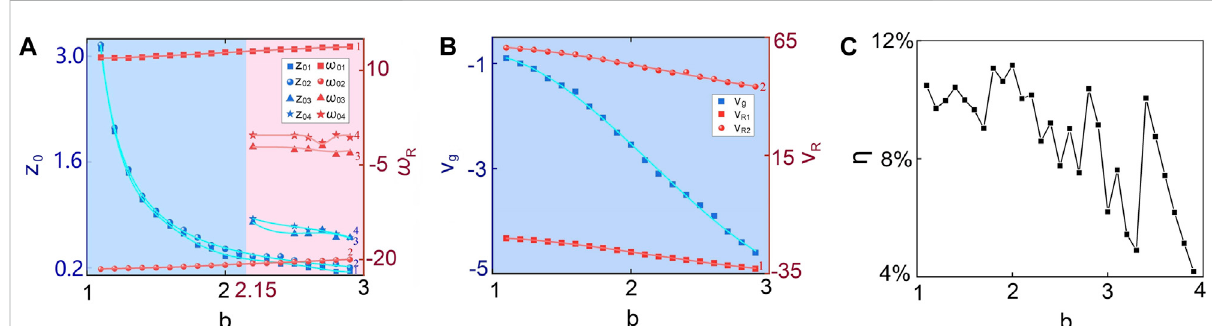
FIGURE 5 AsinFigure2for β 3 =0.24,and β 4 =0.096.Thevariationsofradiationdistances( z 0 j ) (A) ,radiationfrequencies( ω 0 j ) (A) ,groupvelocityof fi rstcellof KMS ( v